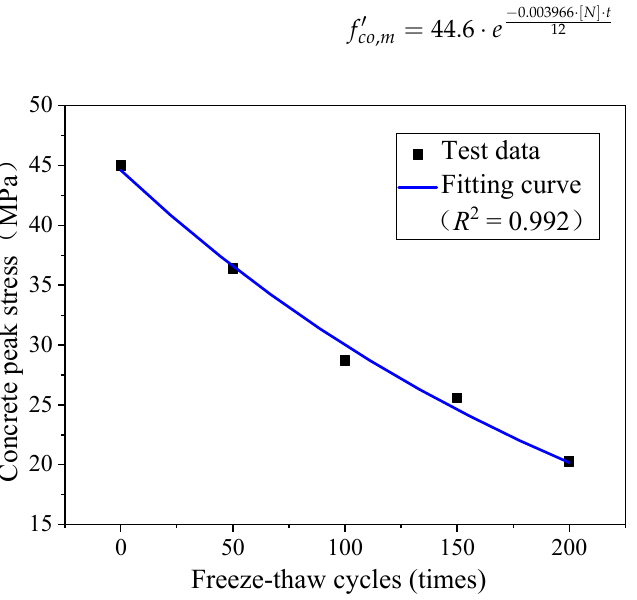
Figure 5. Fitting results for the peak stress of the concrete considering the combined action of freeze–thaw and chloride-induced corrosion.